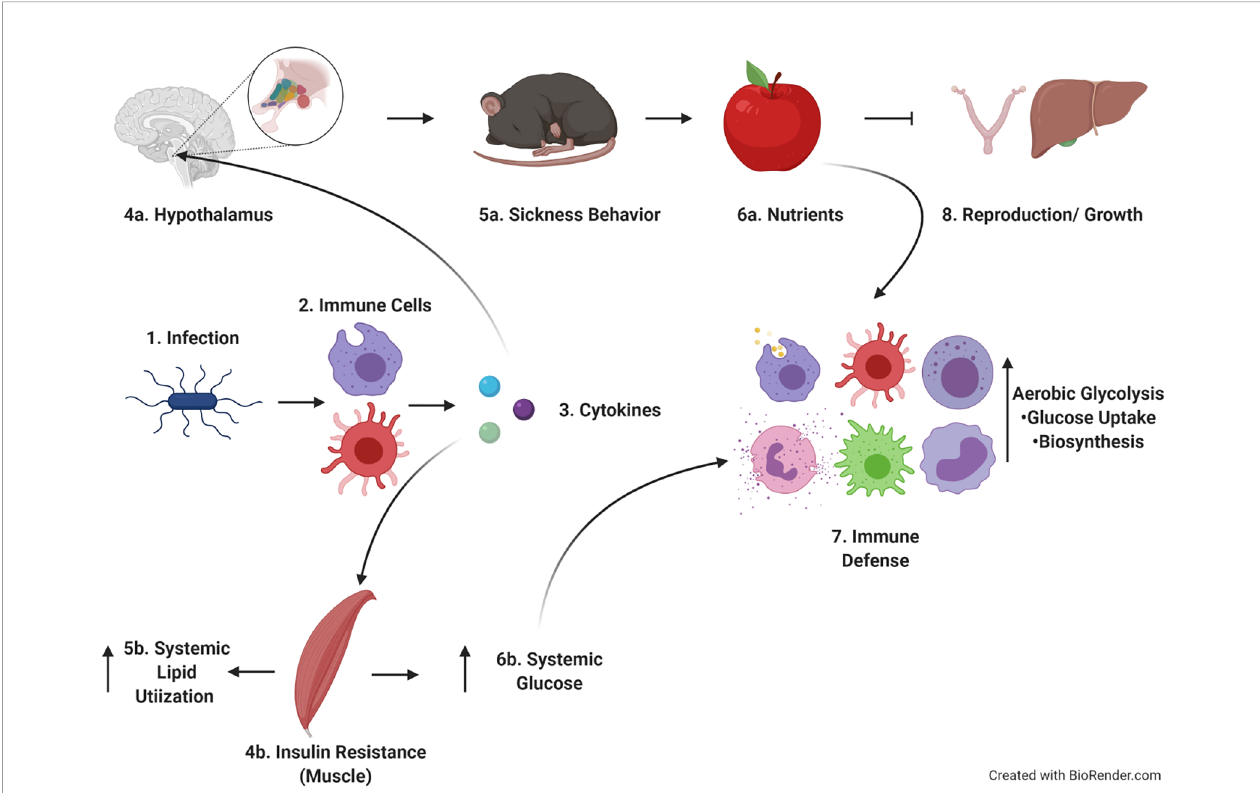
FIGURE 8 | Hypothetical model of fi ndings within the context of life history theory. Upon infection, immune cells produce cytokines which act on both brain and muscle. The effects on the brain lead to sickness behavior and cause tradeoffs with activity, reproduction and growth. Cytokines acting on muscle leads to insulin resistance and increased systemic lipid utilization, allowing increased circulating glucose to be used by immune cells as they proliferate and develop effector function. Image created in